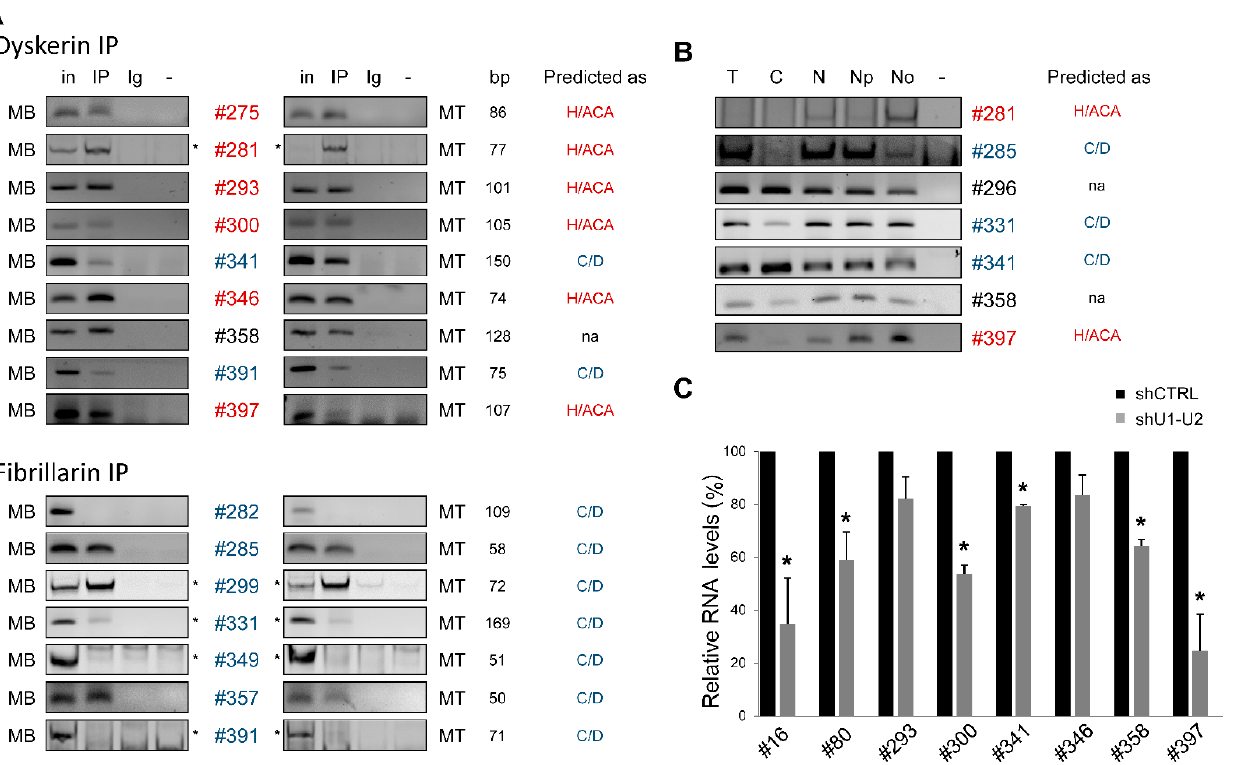
Figure 4. New genuine intergenic snoRNAs are splicing-dependent. ( A ) IP-PCR against Dyskerin and Fibrillarin was performed to analyze the affiliation of the new intergenic snoRNA candidates (#) to their respective snoRNP complex (n = 2). The class of snoRNA (H/ACA, C/D or SCA) predicted by the webservers is indicated on the right. MB, myoblast; MT, myotube; in, 5% input; IP, immunoprecipitation; Ig, V5 epitope antibody (irrelevant antibody); -, mock PCR; bp, base pair. ( B ) Isolation of nucleoli by sucrose cushion centrifugation was performed on MBs to check the accumulation of in- tergenic snoRNA candidates (#) in nucleoli (for more information, see Figure 3). The class of snoRNA (H/ACA, C/D or SCA) predicted by the webservers is indicated on the right. T, total fraction; C, cytoplasmic fraction; N, nuclear fraction; Np, nucleoplasmic fraction; No, nucleolar fraction; -, mock PCR. ( C ) Total RNA was extracted from MBs transfected with shRNAs targeting snRNP70, PRP8 and U2AF65 (shU1-U2) or Luciferase (shCTRL). Then, new intergenic snoRNA can- didates (#) were detected by RT-PCR (n = 3). Intronic snoRNA candidates #16 and #80 known to be splicing-dependent were used as a positive control. Lys-tRNA was used as an invariant control. -, mock PCR. A quantification of the re- maining RNA levels after RNA interference and adjusted to shCTRL was performed. Significant differences were as- sessed using Student’s t -test (* p < 0.05). Error bars represent standard error at the mean (SEM).